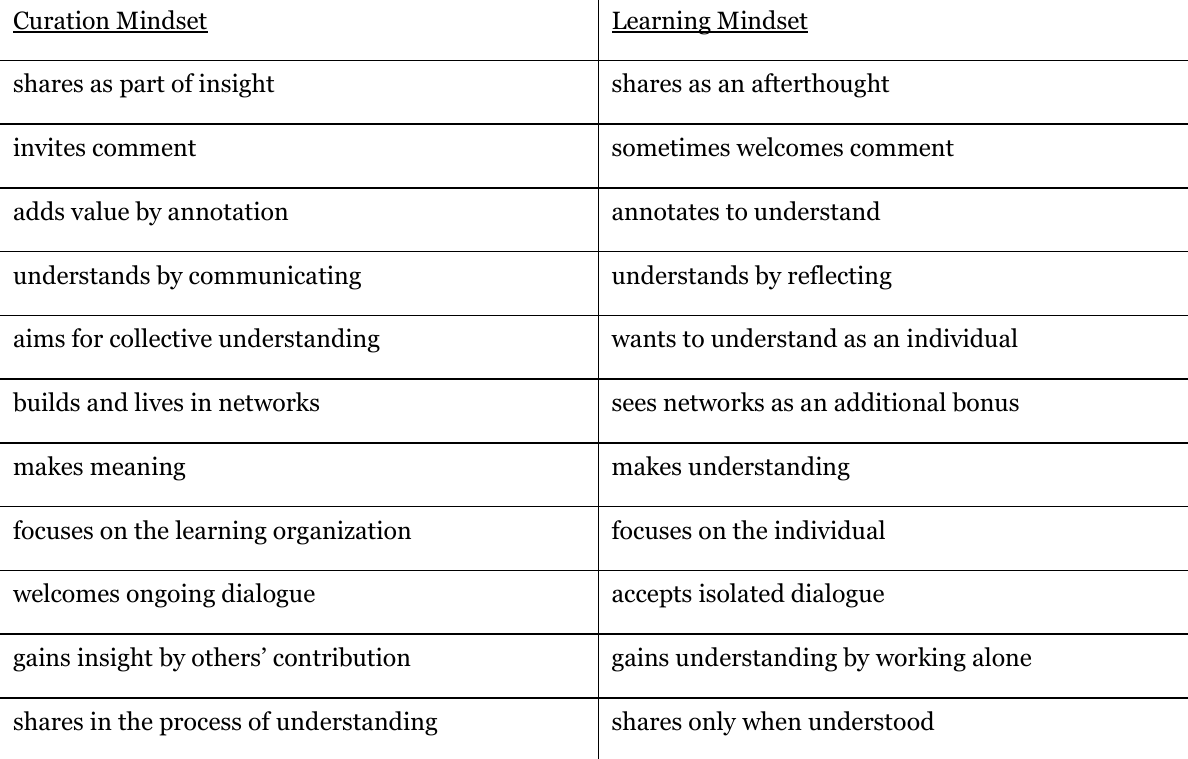
Characteristics of a Curation Mindset and a Learning Mindset (Betts & Payne, 2016, p. 10